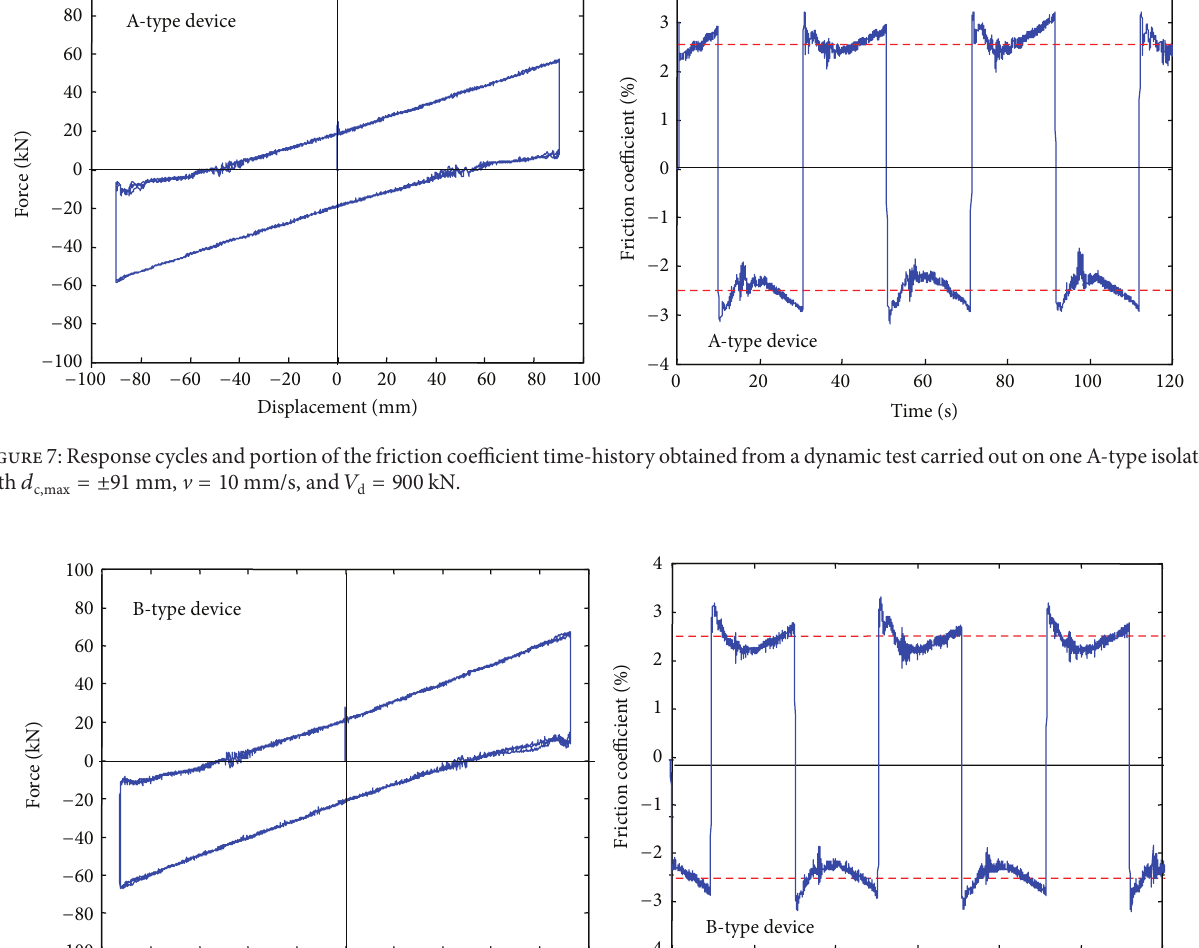
isolator (A-type, situated on the upper right corner in plan of B3 block), again along 𝑦 , derived from the same MCE-scaled input